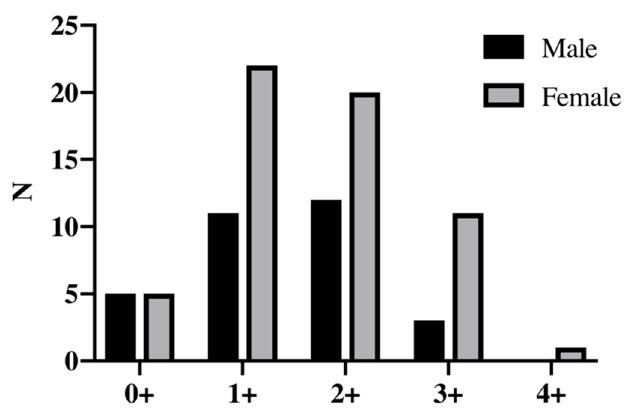
Figure 3. Distribution by age class of male and female S. fontinalis .